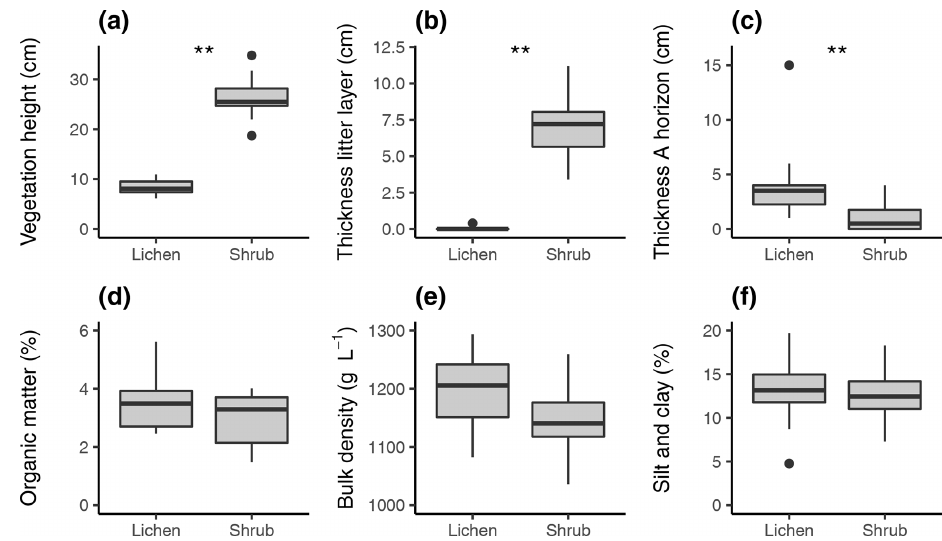
Figure 3. Difference in vegetation height (a) , thickness of the litter layer (b) , thickness of the A horizon (c) , organic matter (d) , bulk density (e) , and silt and clay fraction (f) between the lichen and shrub plots of 2018. Asterisks indicate the significance according to the Wilcoxon signed rank test. ∗∗ : p value < 0 . 01; no asterisks means no significant difference. n = 10 for each